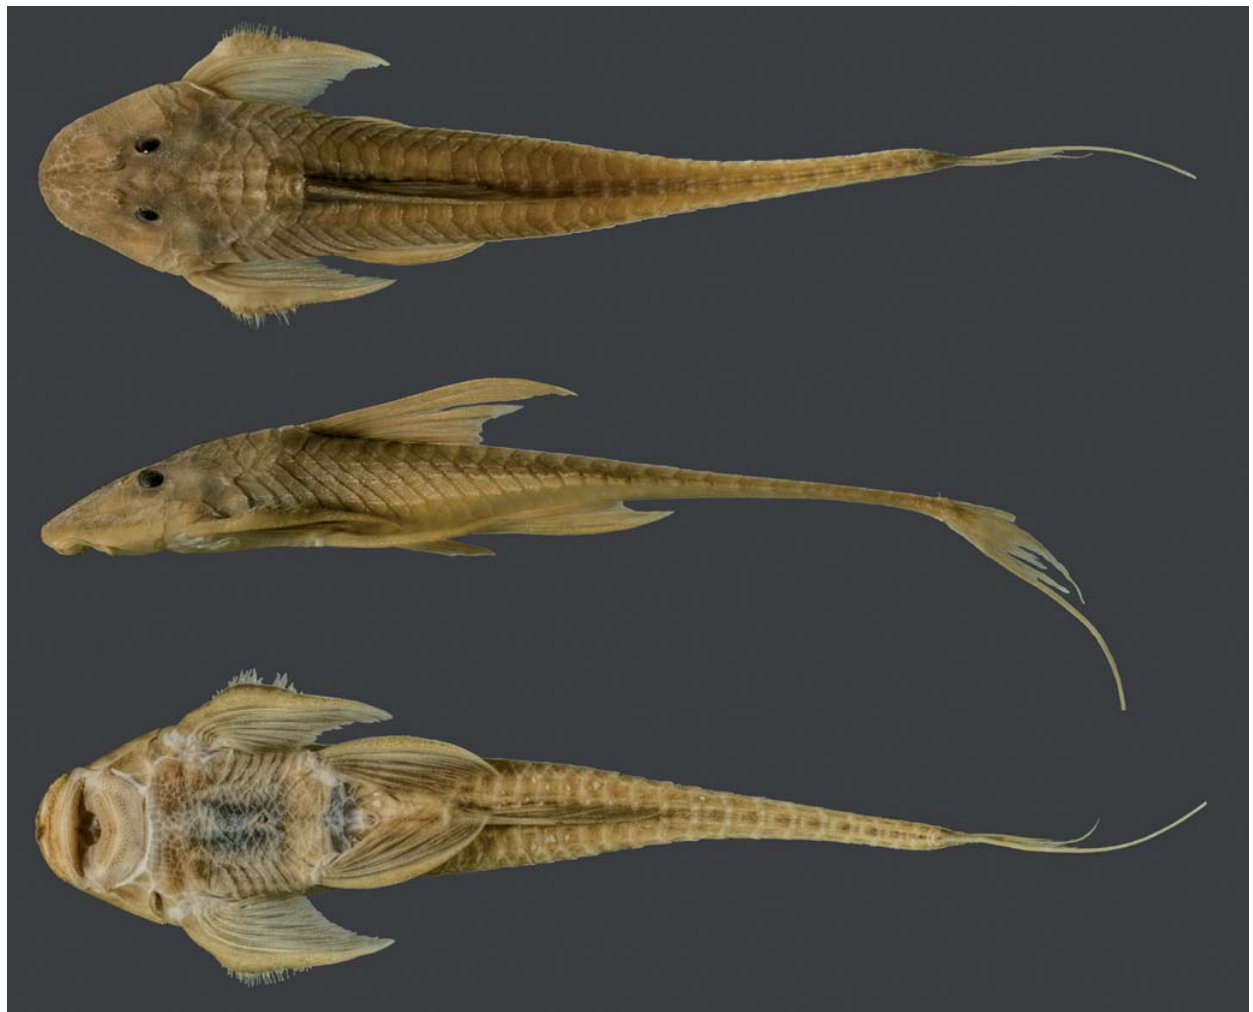
Fig. 13. Lamontichthys parakana , INPA 3010, 112.7 mm SL, holotype. Dorsal, lateral and ventral